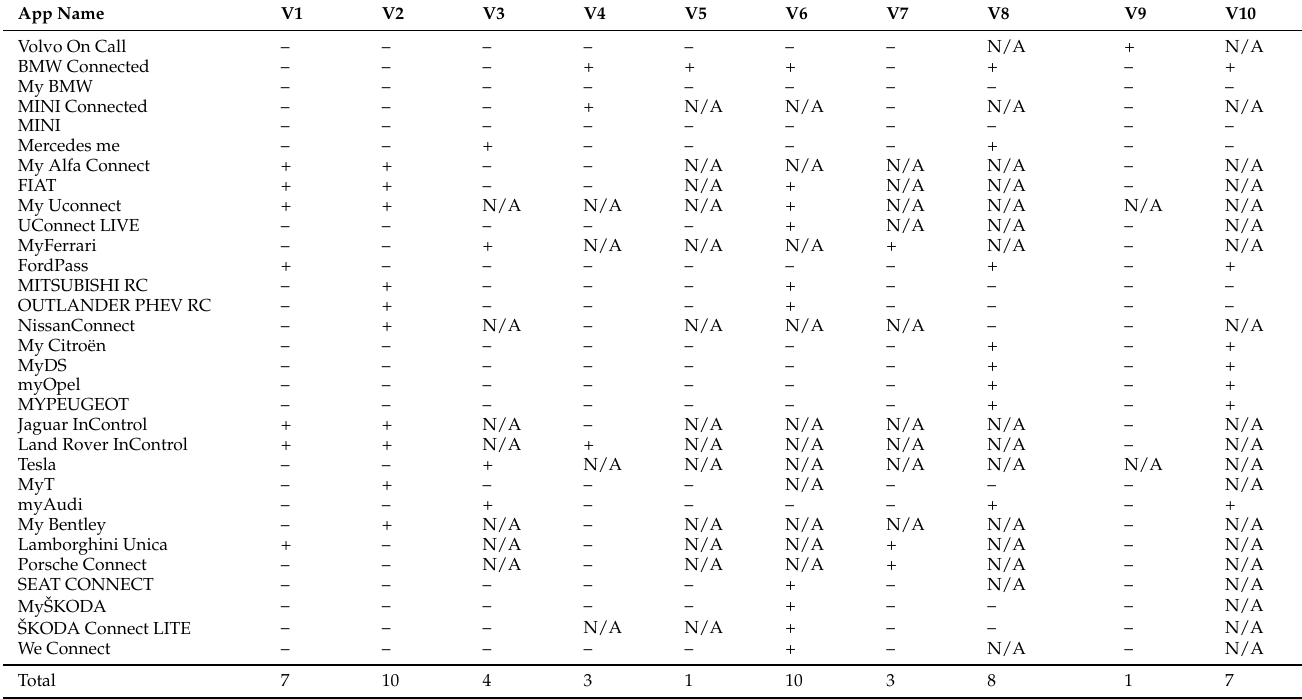
Table 10. Different VIN registration/authentication methods. V1: Paid subscription, V2: Limited model support, V3: Face-to-face proof of ownership, V4: Partial VIN, V5: PIN in vehicle, V6: Physical access, V7: Online proof of ownership, V8: Acceptance of unsupported model VINs, V9: Email address verification with PIN, V10: Acceptance of the same VIN with multiple accounts without